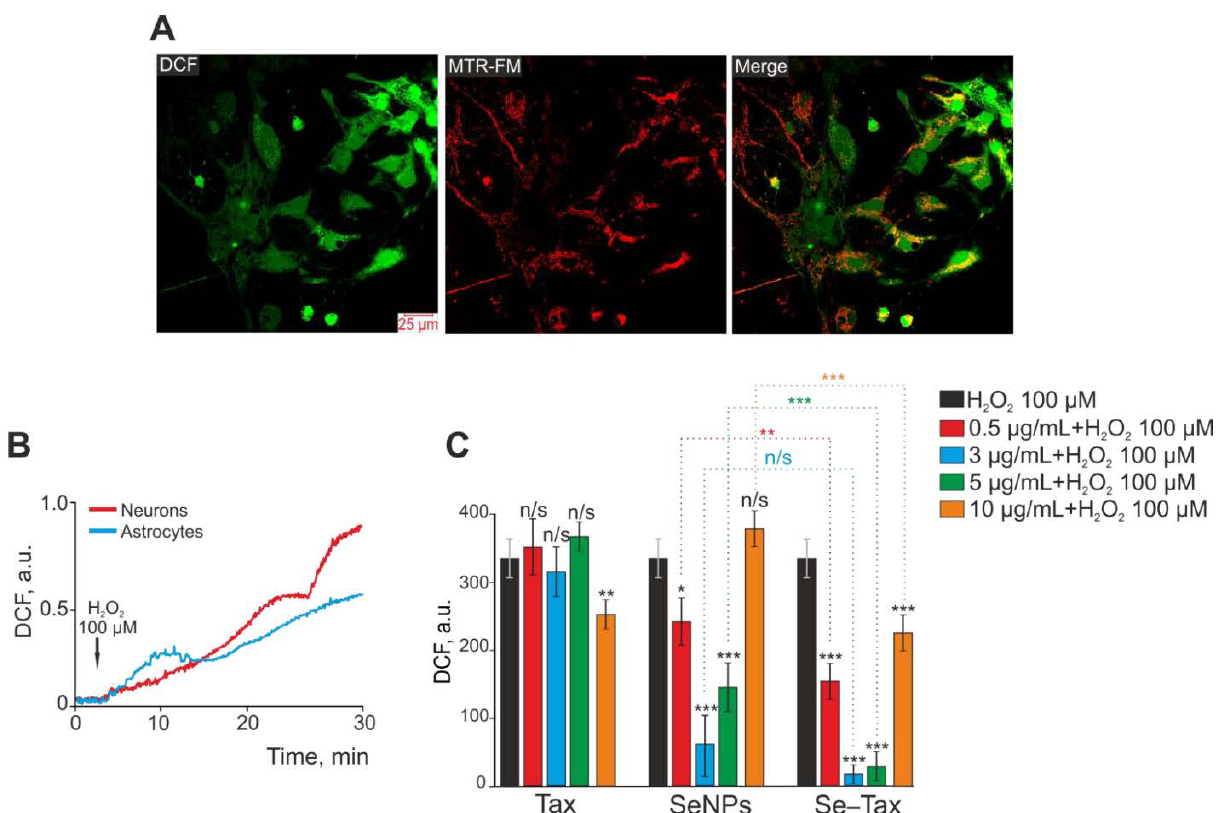
Figure 8. Taxifolin (TAX), selenium nanoparticles (SeNPs), and selenium–taxifolin nanocomplex (Se–TAX) pretreatments of cerebral cortex cells for 24 h have a dose-dependent impact on ROS generation induced by 100 μM H 2 O 2 . ( A ) Confocal fluorescence images with simultaneous labeling of cerebral cortex cells with a DCF probe (to quantify ROS generation), a mitochondrial probe (MitoTracker Red FM, MTR-FM), or a combination image (Merge). ( B ) Generation of ROS in cerebral cortex neurons (red curve) and astrocytes (blue curve) after adding 100 μM H 2 O 2 to the cell culture. ( C ) Impact of TAX, SeNPs, and Se–TAX, at varying doses, on the H 2 O 2 -induced ROS generation after 24 h cell incubation (measurements performed using a microplate reader). Adapted with permission from [97] . (*** p < 0.001; ** p < 0.01 and * p < 0.05. n/s—insignificant differences). Copy- right {2022} Science-HHS Public Access (PubMedCentral).